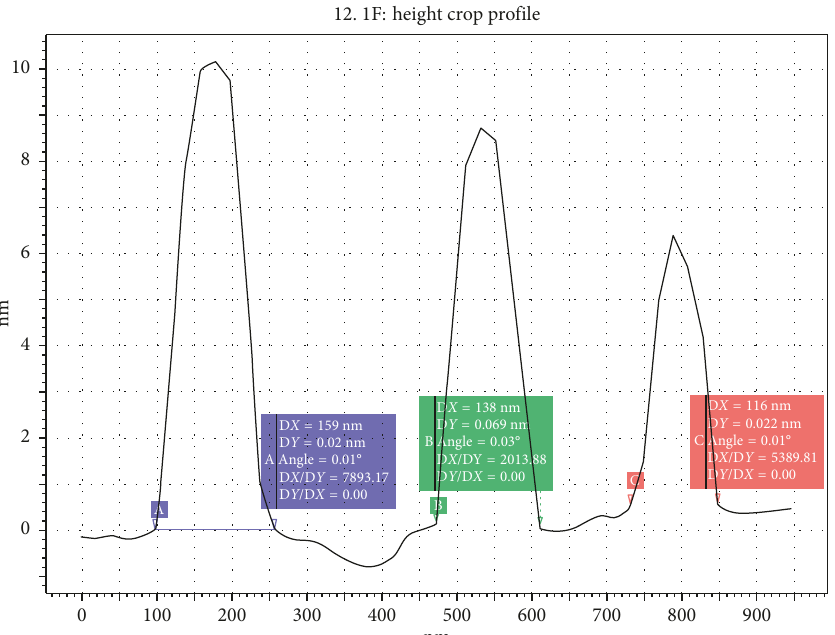
Figure 11: The linear dimensions of the “hillocks” corresponding to the indicated points 4, 5, and 6 in Figure 8.